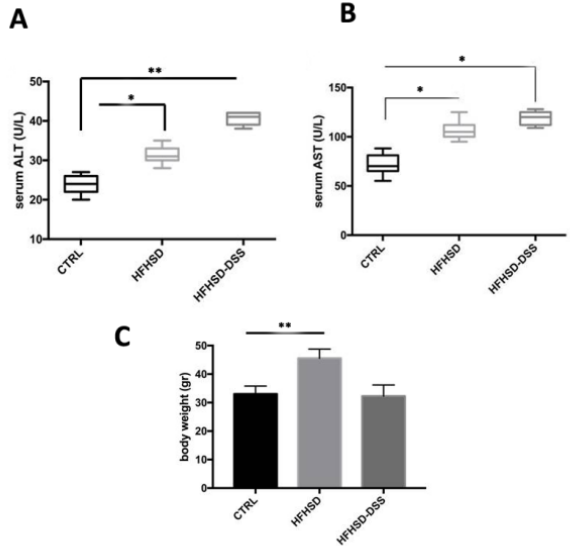
Figure A1. Assessment of serum Alanine Aminotransferase (ALT) ( A ), Aspartate Aminotransferase (AST) concentrations ( B ) and body weight change ( C ) in control (CTRL), high-fat and high-sugar diet (HFHSD) induced steatosis mice model and in high-fat and high-sugar diet plus dextran sodium sulfate (HFHSD-DSS)–steatohepatitis mice model, after 13 weeks of treatment. Each value is presented as the mean ± SD for seven mice. Statistical significance: * p < 0.05; ** p < 0.01.